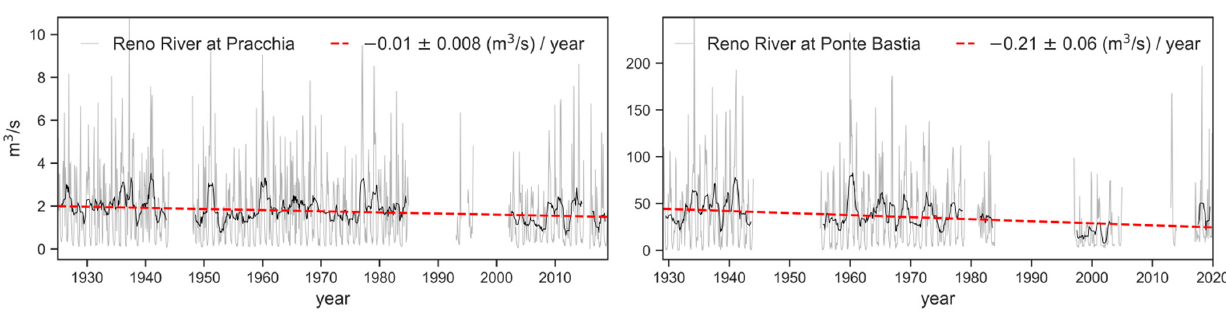
Figure A1. Historical time series of Reno River discharge, and related linear trends, at Pracchia and Ponte Bastia (for locations see Figure 1).